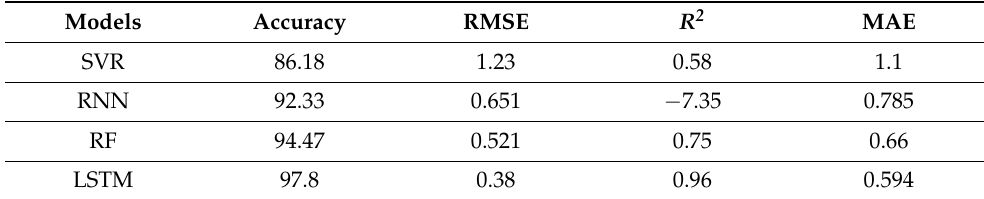
Table 5. Comparison of different ML